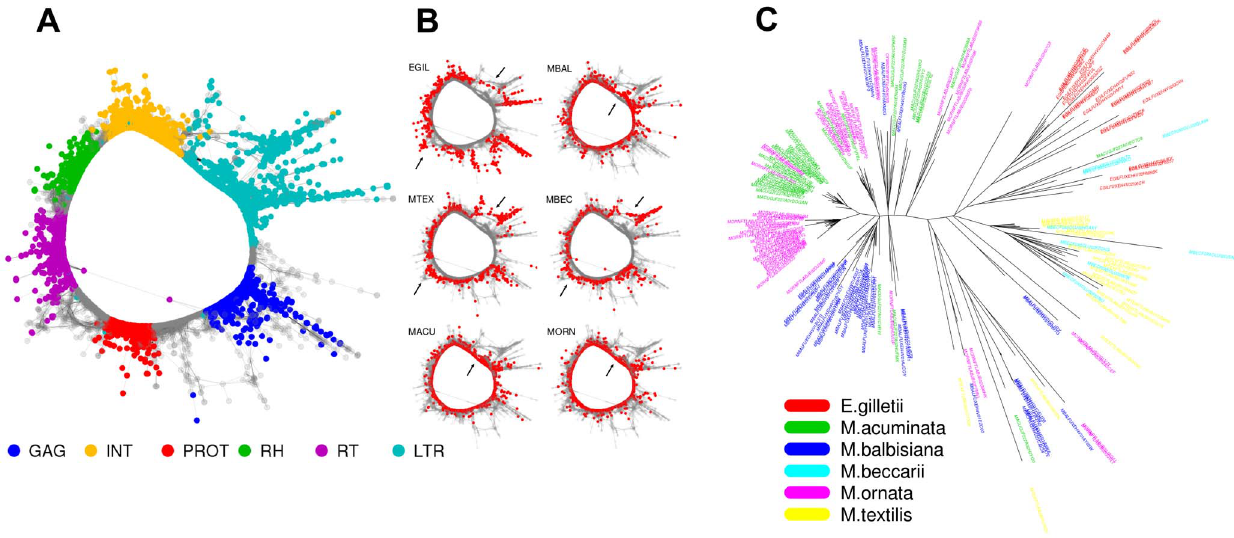
Figure 5. Variability of sequences within cluster CL18. (A) Sequence reads are represented by nodes of the graph and reads with identity of at least 90% with minimal overlap of 110 nt are connected by lines. Graph layout was calculated using the 3D version of the Fruchterman and Reingold algorithm [55] from which a 2D projection is shown. Reads are colored based on their similarity to conserved coding domains of LTR retrotransposons. Reads from LTR regions are colored by light blue. (B) Nodes of the graph are colored based on their species of origin. The six identical graphs show reads derived from each species in red; remaining reads are gray to highlight species-specific parts of the graphs. The parts of the graphs that represent the most variable sequence regions in CRM CL18 element, which can differentiate between species, are labeled by black arrows. (C) Maximum-likelihood tree based on nucleotide alignment of sequences covering the reverse transcriptase protein domain of CRM CL18. Sequence read names are colored based on the species of origin.